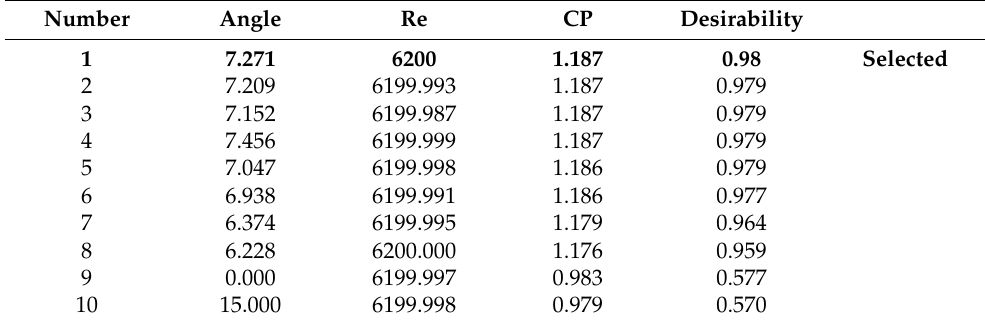
Table 5. Optimization results for the inlet tapered